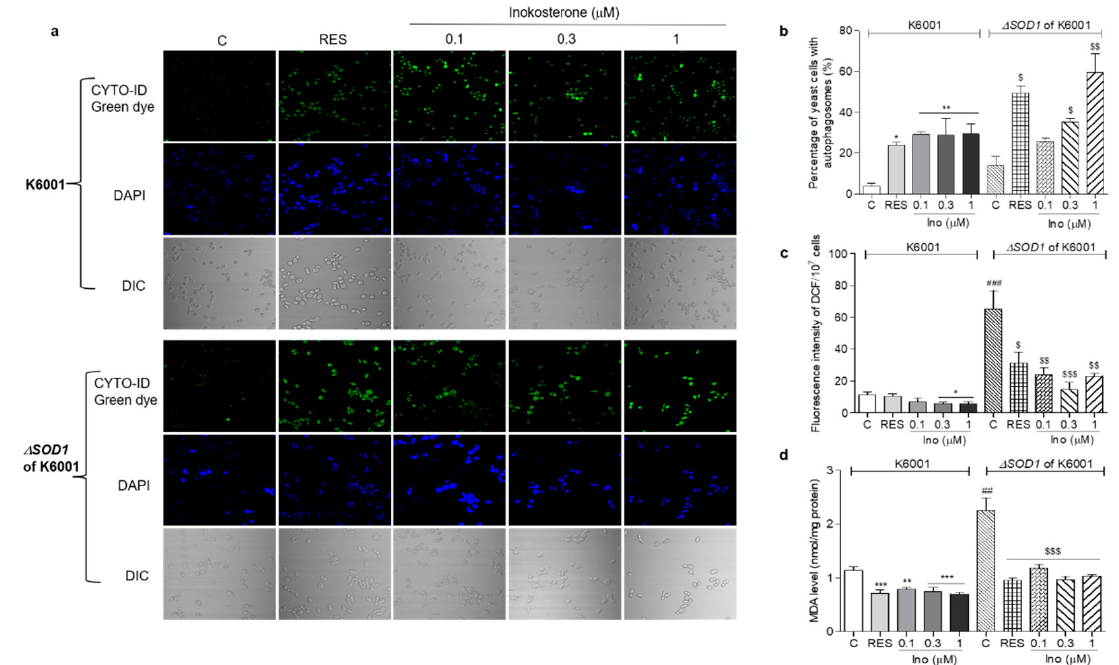
Figure 8. Effects of inokosterone on the autophagy, ROS, and MDA levels of K6001 and ∆ sod1 yeasts with a K6001 background. ( a ) The autophagy in K6001 and ∆ sod1 yeasts with a K6001 background induced by inokosterone at different doses. ( b ) The digital result of autophagy in K6001 and ∆ sod1 yeasts in ( a ). ( c , d ) The ROS and MDA levels of K6001 and ∆ sod1 yeasts with a K6001 background, respectively. The number of repeats was four, and the data are presented as the mean ± SEM. *, **, and *** indicate significant differences from the normal control group of K6001 yeast at p < 0.05, p < 0.01, and p < 0.001, respectively. ## and ### represent significant differences between the control of K6001 and the control of the ∆ sod1 yeasts at p < 0.01 and p < 0.001. $, $$ and $$$ indicate significant differences from the normal control group of ∆ sod1 yeast at p < 0.05, p < 0.01, and p < 0.001, respec- tively.